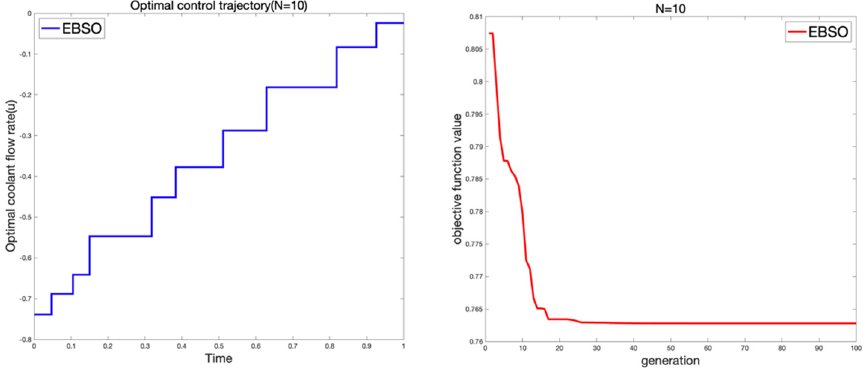
Figure 18. Optimal control trajectory and iteration curve ( N = 10).